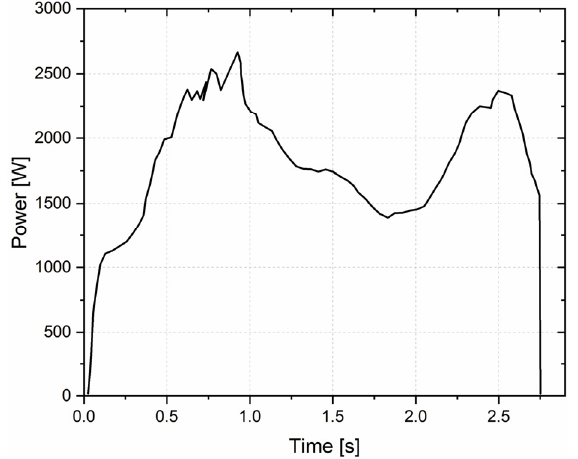
Figure 3. Time x power curve for the optimized U-Joining process using horizontal vibration.